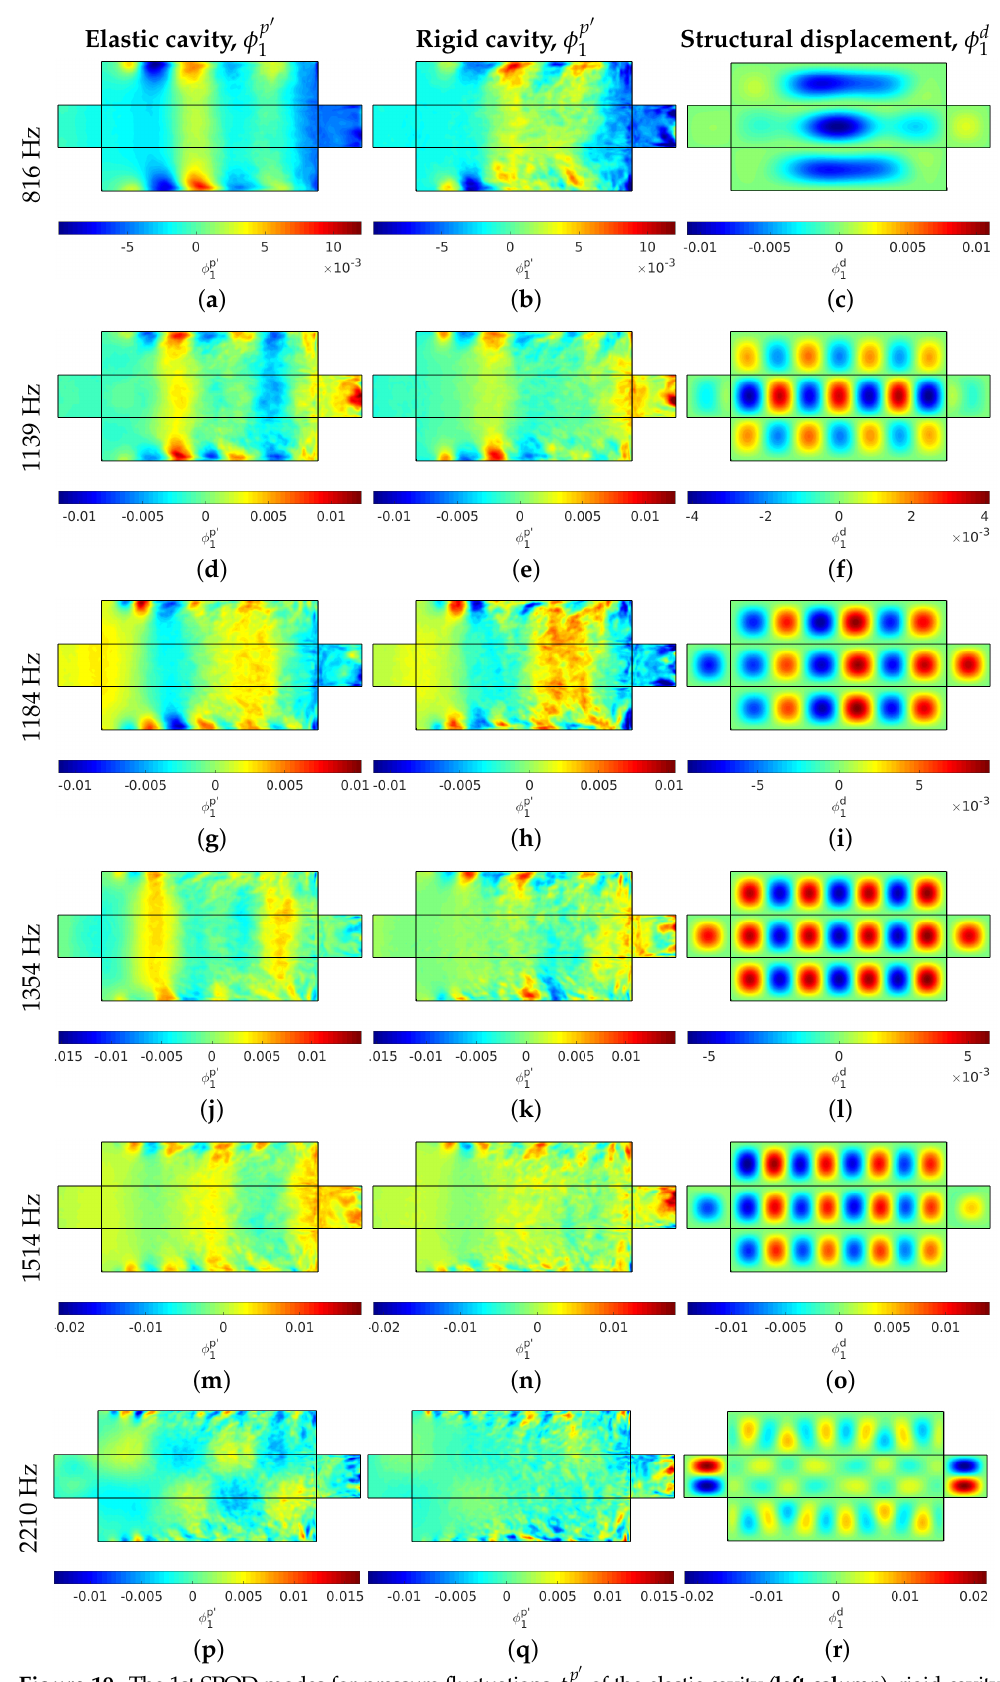
Figure 19. The 1st SPOD modes for pressure fluctuations φ p ( middlecolumn ),andfordisplacements φ d